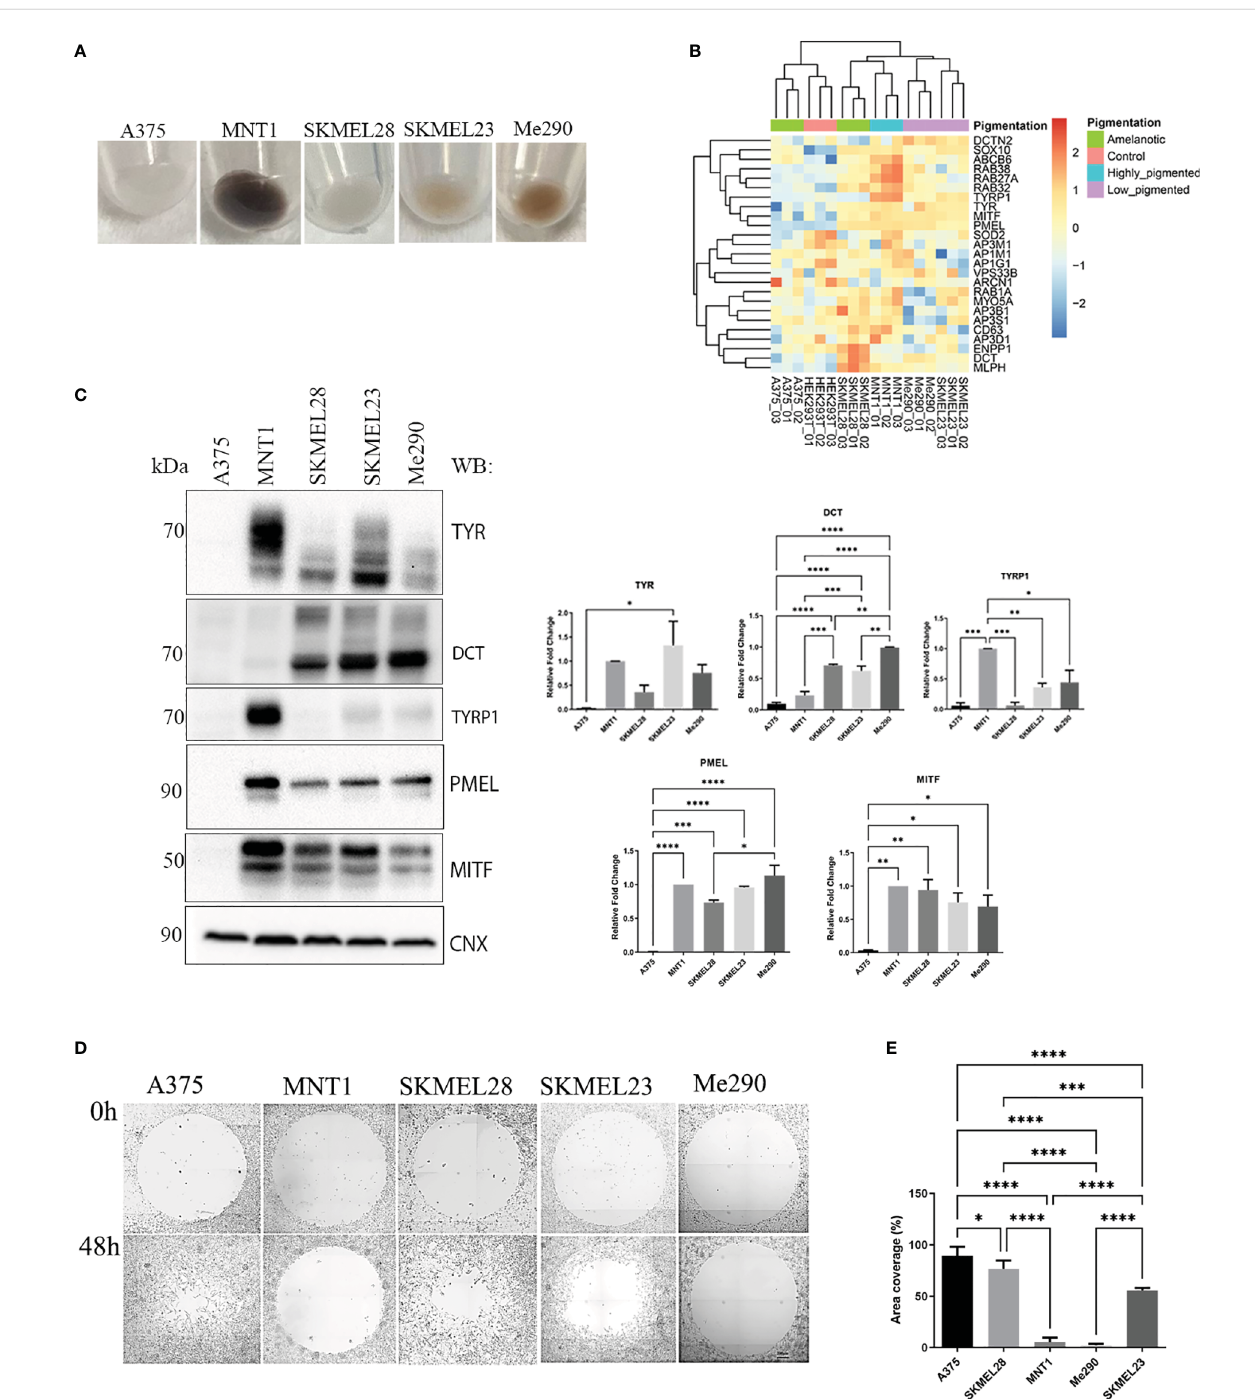
FIGURE 1 Expression of melanin related proteins in pigmented and amelanotic melanoma cells and assessment of cells migration. (A) Visual comparison between amelanotic cells (A375, SKMEL28) and pigmented cells (MNT1, SKMEL23, Me290). (B) Heatmap representation of log2 transformed LFQ intensity values for proteins annotated for pigmentation (GO:0043473). (C) Western blot analysis of TYR, DCT, TYRP1, PMEL, microphthalmia-associated transcription factor (MITF) protein expressions in A375, MNT1, SKMEL28, SKMEL23 and Me290 and quantitative representation of relative protein expressions (one-way ANOVA analysis; ****p < 0.0001; ***p < 0.001; **p < 0.01; *p < 0.05; n=3). Data are presented as mean ± SEM (D) Migration assay for A375, MNT1, SKMEL28, SKMEL23 and Me290 melanoma cell lines over a period of 2 days. (E) Measurements of area coverage indicating the signi fi cant differences between the fi ve cell lines (one-way ANOVA analysis; ****p < 0.0001; ***p < 0.001). The measurements were conducted on at least 3